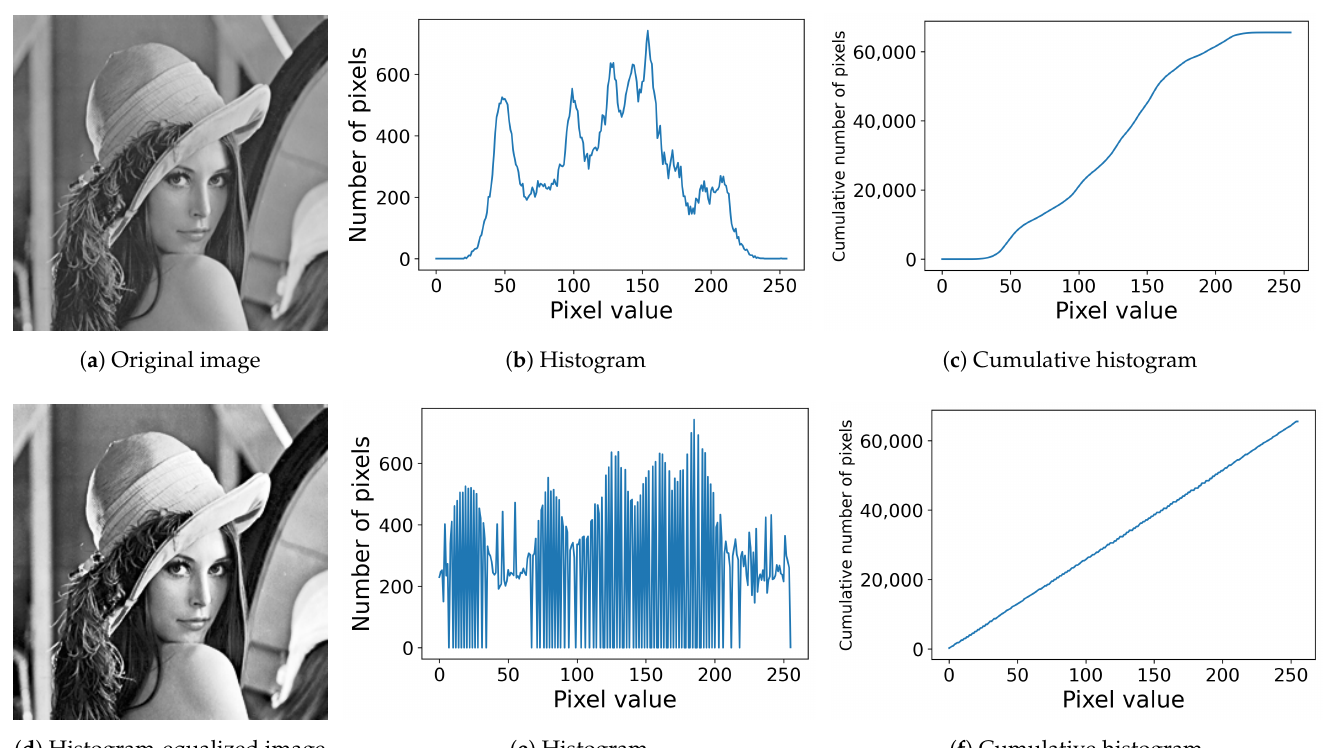
Figure 1. Histogram equalization: ( a ) an original image with 256 × 256 pixels; ( b ) the histogram of the original image; ( c ) the cumulative histogram of the original image; ( d ) the histogram-equalized image; ( e ) the histogram of the image in ( d ); ( f ) the cumulative histogram of the image in ( d